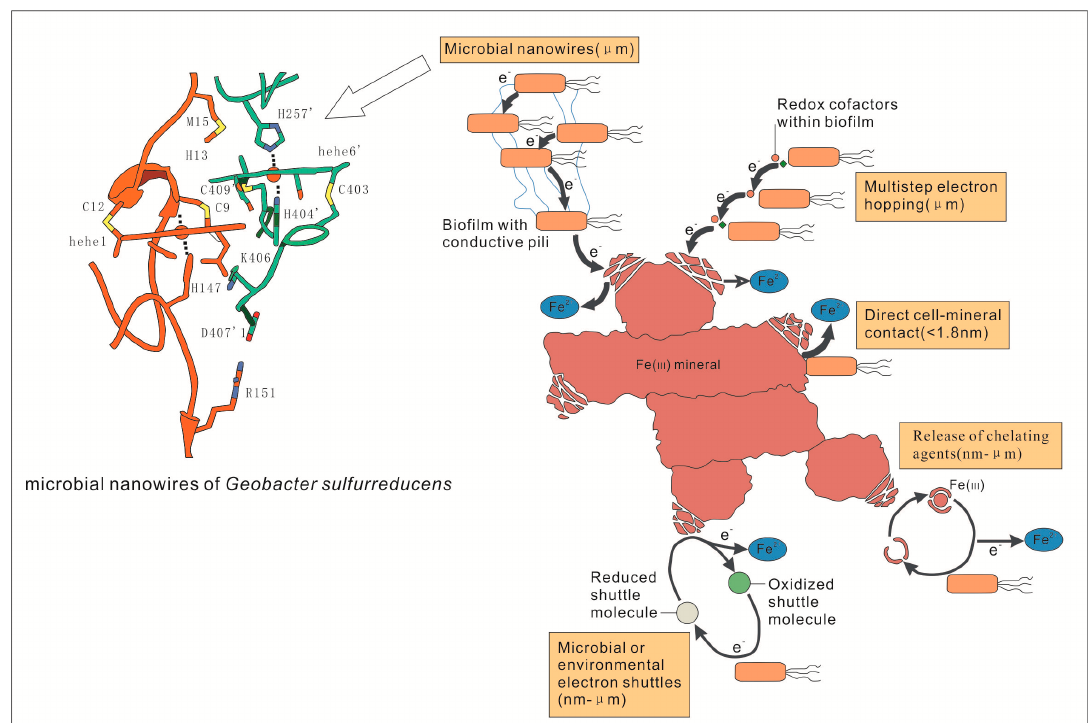
Figure 2. Mechanisms of electron transfer from microorganisms to Fe(III) minerals [8,72].